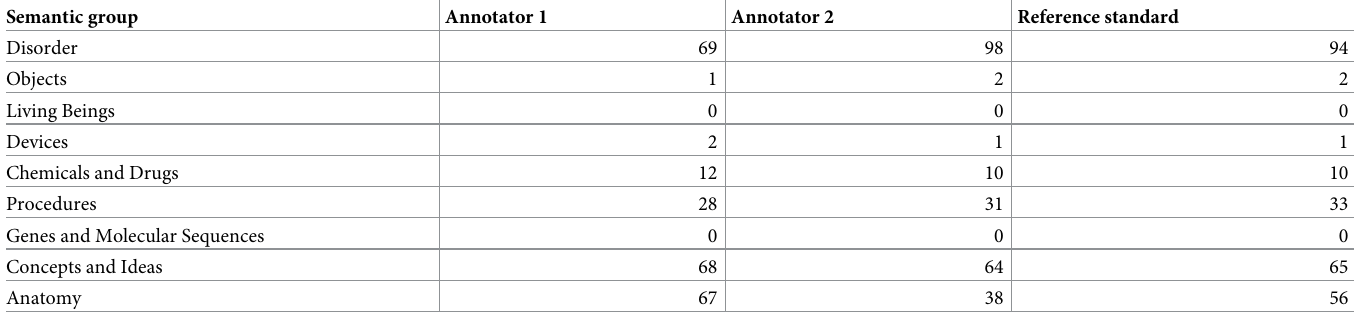
Table 3. The number of concepts from each semantic group that were used by each annotator and the reference standard for coding the 20 medical text snippets. Semantic